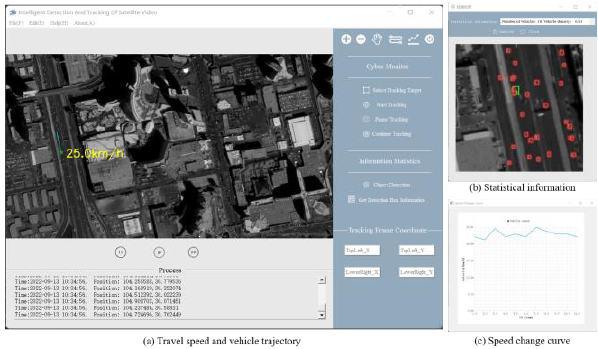
Figure 4. Vehicle monitoring platform information.